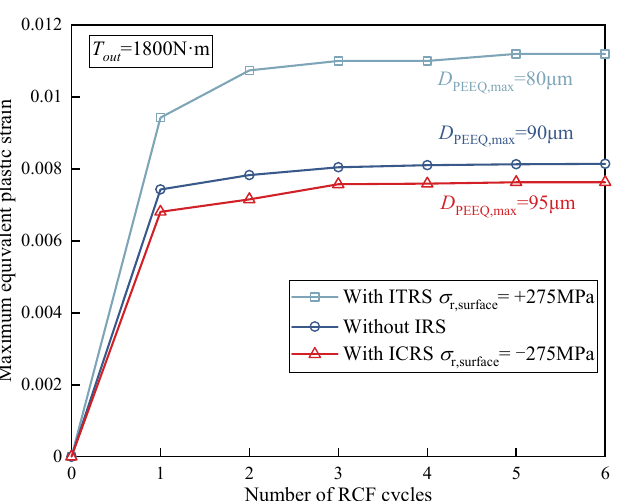
Figure 21. The effect of initial residual stresses on the maximum equivalent plastic strain (Max PEEQ) in RCF cycle ( T out = 1800 N · m, P h = 2.34 GPa).